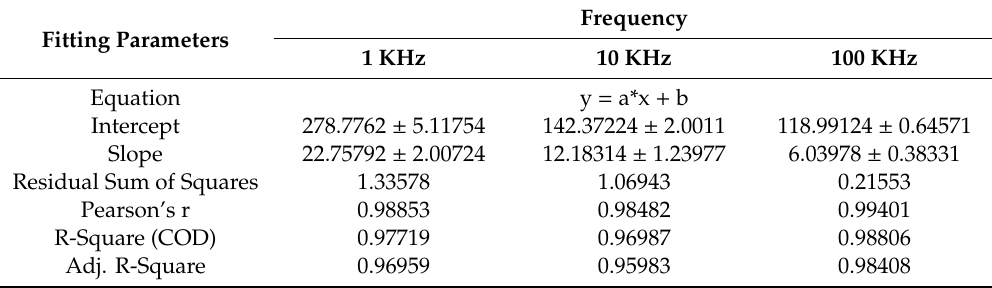
Figure 8. ( a ) Extracted results from the mean impedance magnitude values for different concentrations of AFB 1 standard solutions tested at 100 KHz ± STD. Different letters (a, b, c) indicate statistically significant different values ( p < 0,05). ( b ) Linear fit curve of the values of the mean impedance magnitude for concentrations of AFB 1 standard (0−10 ng/mL) tested at 100 KHz. Table 1. Fitting parameters from the linear fit curve of the normalized values of the mean impedance magnitude for concentrations of AFB 1 spiked pistachio samples (1−100 ng/mL) tested at three different frequencies (1 KHz, 10 KHz, 100 KHz).